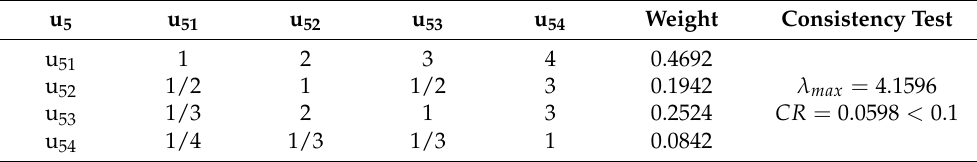
Table 12. The judgment matrix and weights of evaluation indicators under u 5 .